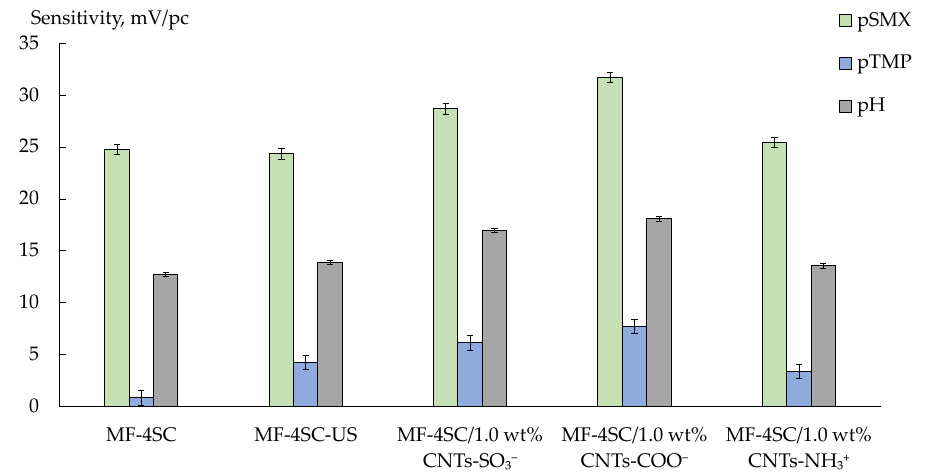
Figure 8. Sensitivity coefficients of DP-sensors based on MF-4S/CNTs membranes to SMX − , TMP + /TMP, and water dissociation products (1.0 × 10 −5 – 1.0 × 10 −3 М , pH 4.53 – 8.31).